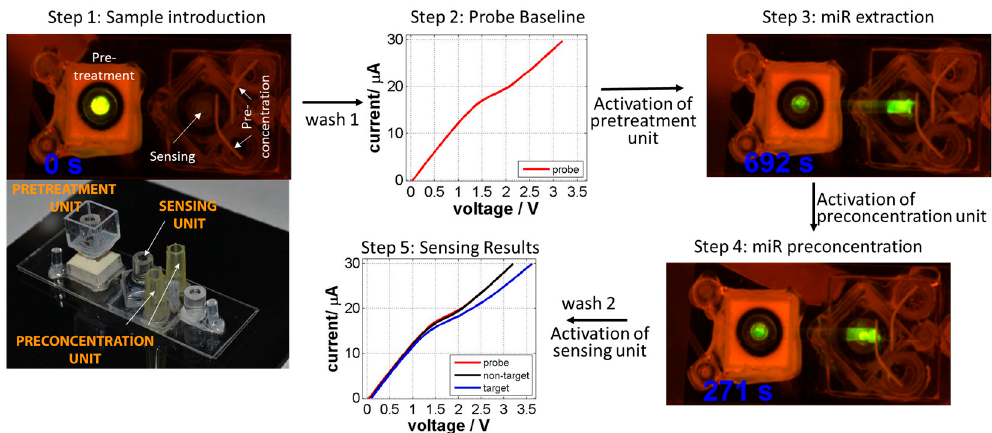
Figure 4. Steps involved in the successful extraction, concentration and detection of miR146a biomarker from oral cancer cell lysate solution. Step 1: The sample is introduced in the pretreatment chamber; Step 2: A baseline CVC is measured for the probe on the sensor; Step 3: An electric field is applied to extract nucleic acid molecules from the pretreatment unit; Step 4: The preconcentration unit is used to concentrate the extracted nucleic acids; Step 5: After allowing target hybridization with the probe, a second CVC is measured to analyze the presence or absence of target.